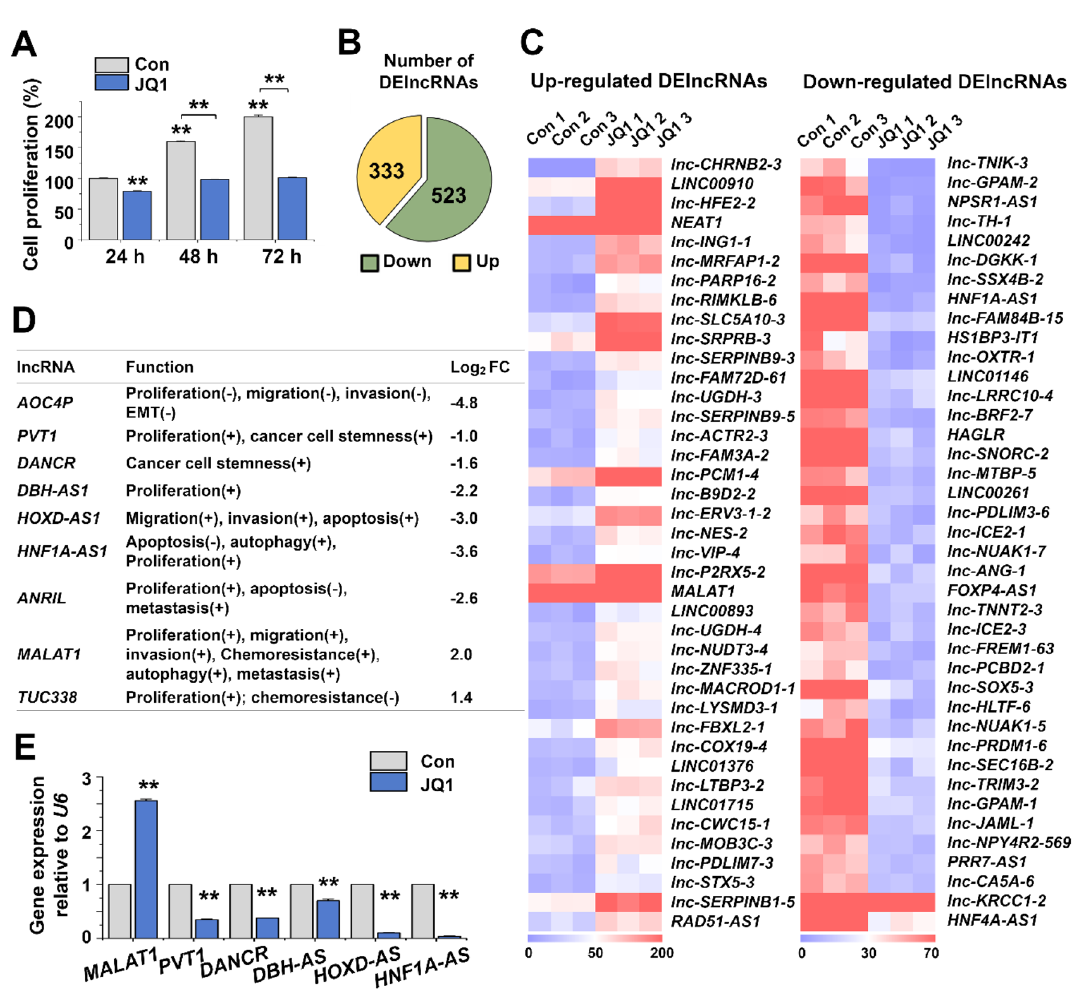
Figure 1. Differential lncRNA expression in JQ1-treated HepG2 cells. ( A ) HepG2 cells were treated with JQ1 (5 µM) or vehicle (DMSO) for the indicated durations, and cell proliferation was determined using a WST-1 assay. The data represent three biological indenpendent experiments. ** p < 0.01. ( B ) Pie chart displaying the number of up-regulated (yellow) and down-regulated (green) lncRNAs. ( C ) Heat map representing the top 40 up- and down-regulated DElncRNAs. ( D ) Log 2 fold changes of 9 selected lncRNAs affected by JQ1 and previously known to be over-activated in HCC. ( E ) qRT-PCR analysis of 6 selected DElncRNAs levels. The data represent three independent experiments. The values are mean ± SD of triplicate wells. ** p <